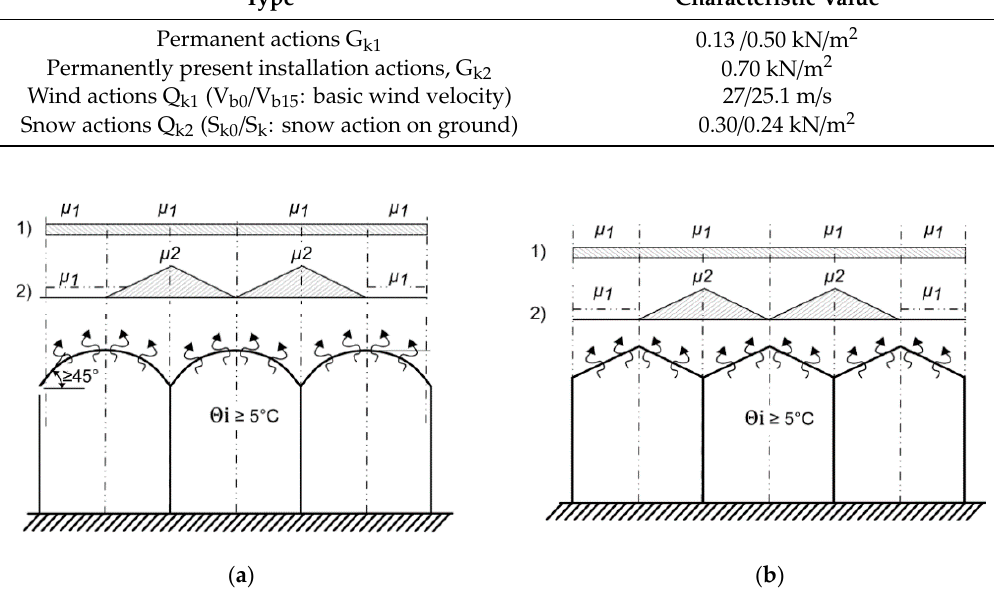
Figure 11. Snow load distribution for (a) vaulted and (b) Venlo-type greenhouses. Case (1), uniform snow load distribution; case (2), snow accumulation [1].